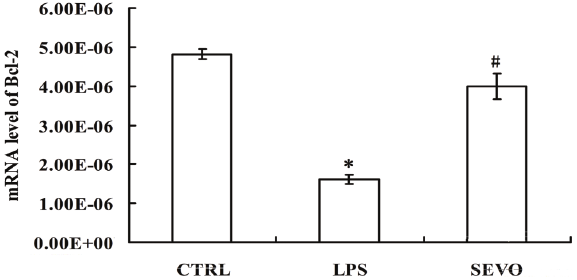
Figure 9. Relative levels of Bcl-2 in lung tissue samples assessed by real-time PCR. CTRL: control group injected intratracheally with normal saline; LPS: injected intratracheally with lipopolysac- charide; SEVO: injected with LPS plus inhaled sevo fl urane for 30 min. Data are reported as means ± SD (n=6 per group). *P o 0.01 vs CTRL; # P o 0.01 vs LPS